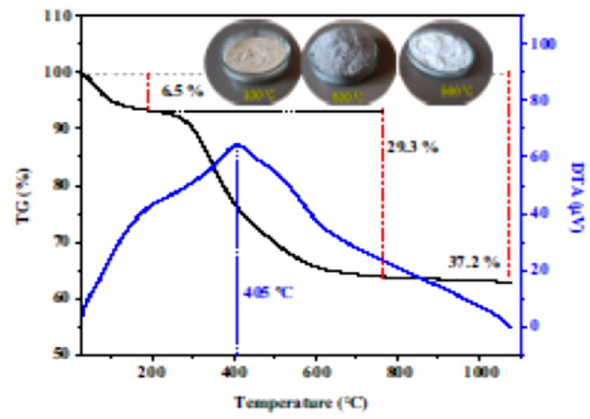
Fig. 20 The TGA of raw goat bone [113]